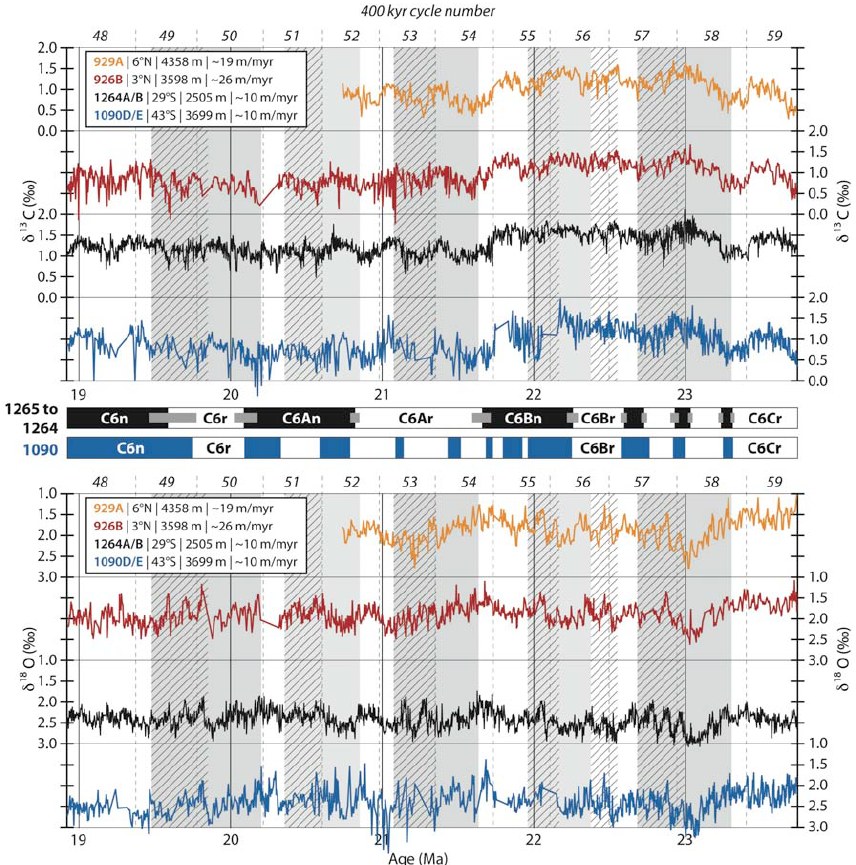
Fig. 3. Comparison of early Miocene stable isotope records. High-resolution Atlantic δ 13 C and δ 18 O (+0.64‰) records of ODP Sites 929, 926 (Flower et al., 1997a; Zachos et al., 1997, 2001b; Paul et al., 2000; P¨alike et al., 2006a; Shackleton et al., 2000), Site 1264 (this study) and Site 1090 (Billups et al., 2002, 2004). Records were matched to Site 1264 in the depth domain using the “Match” algorithm (Lisiecki and Lisiecki, 2002) and then plotted on the ATNTS-based age model of Site 1264. The Walvis Ridge magnetostratigraphy (Bowles, 2006) has been transferred from Site 1265 to Site 1264 (see Fig. 2). The vertical dashed lines mark the boundaries of the 400kyr cycles (Wade and P¨alike, 2004). Latitude, present water depth and average sedimentation rates are given for each